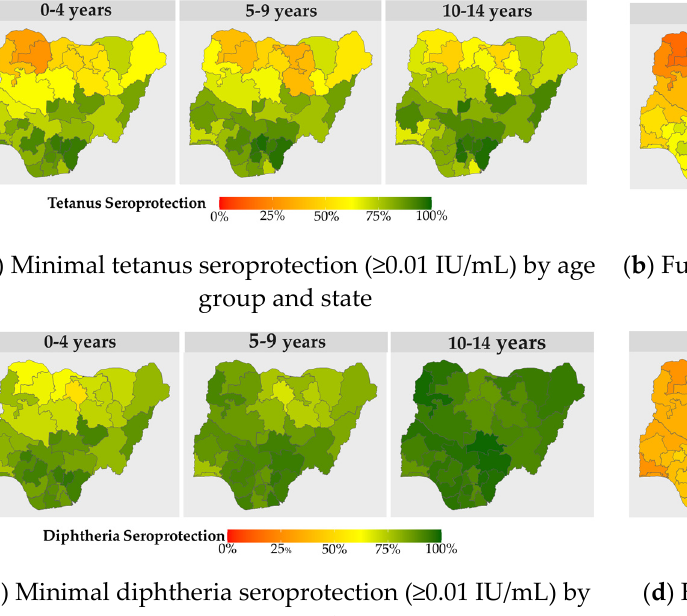
Figure 1. Tetanus and diphtheria minimal and full seroprotection among children aged <15 years by age group and state, Nigeria, 2018 ( a – d ).